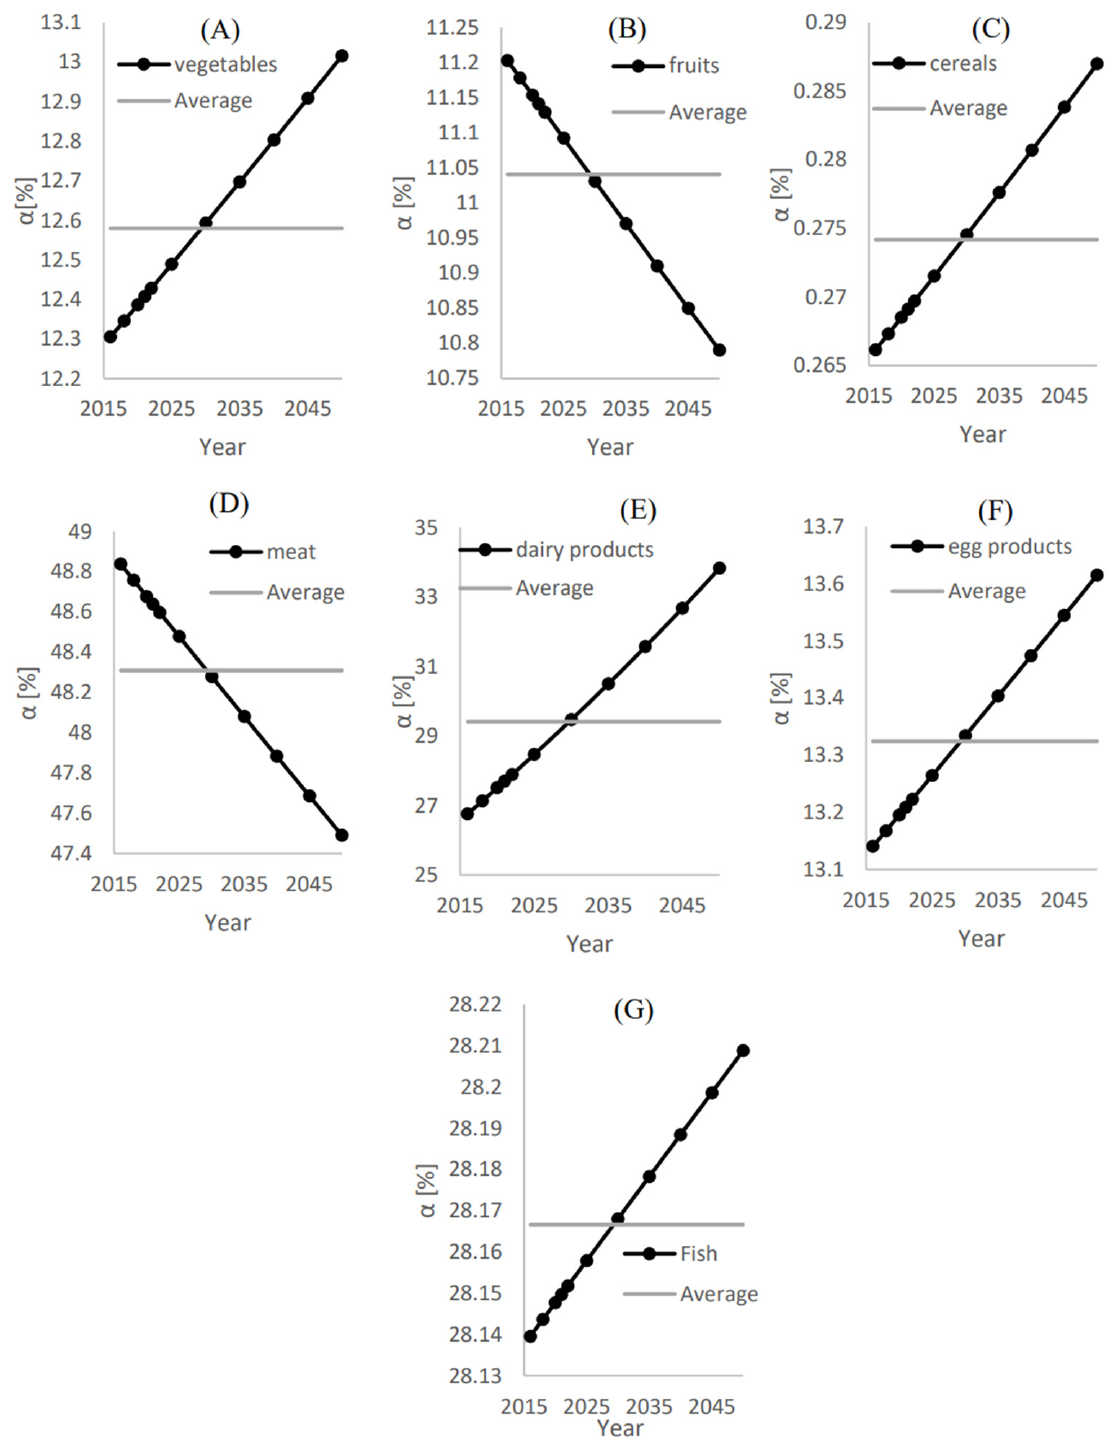
Figure 6. The annual and average ratios of the local food supply to the total demand ( α i ) and ( α ) for